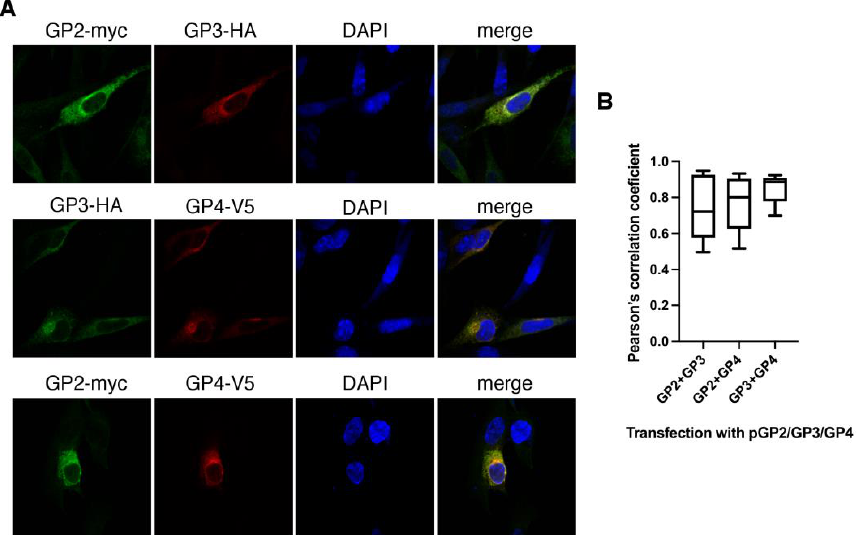
Figure 5. GP2-myc, GP3-HA, and GP4-V5 co-localization as shown by confocal microscopy. HK-21 cells were transfected with pGP2/GP3/GP4. ( A ) Cells were fixed 22 h post-transfection and subjected to double staining with antibody pairs against protein tags. DAPI, a nucleus stain, was added to the mounting medium. ( B ) Experiments were performed in duplicates and at least 10 cells per experiment were used to quantify the co-localization in 3D in Huygens Professional software. Pearson’s correlation coefficient graphs were generated with Prism software (GraphPad Software, San Diego, California, USA). Untransfected cells did not show fluorescence.